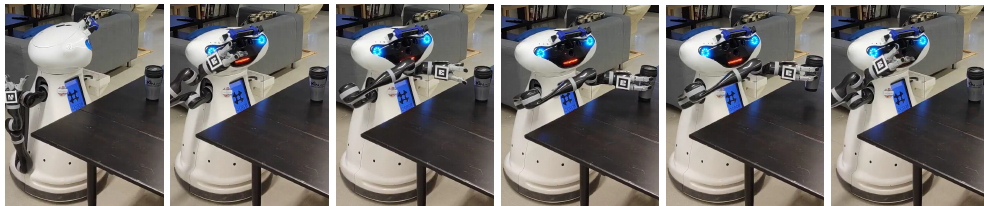
Figure 7. Successful Pick and Place execution by the Mbot